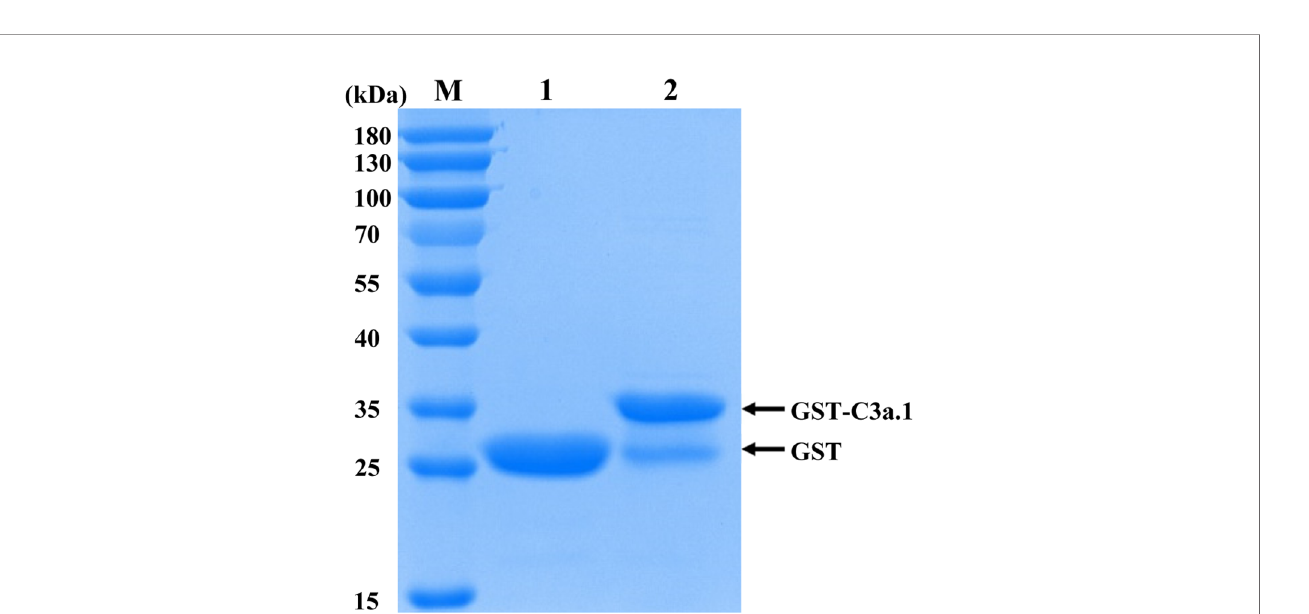
FIGURE 4 | SDS-PAGE analysis of the puri fi ed GST and GST-C3a.1 proteins. M, marker (Thermo); lane 1, puri fi ed GST protein; lane 2, puri fi ed GST-C3a.1